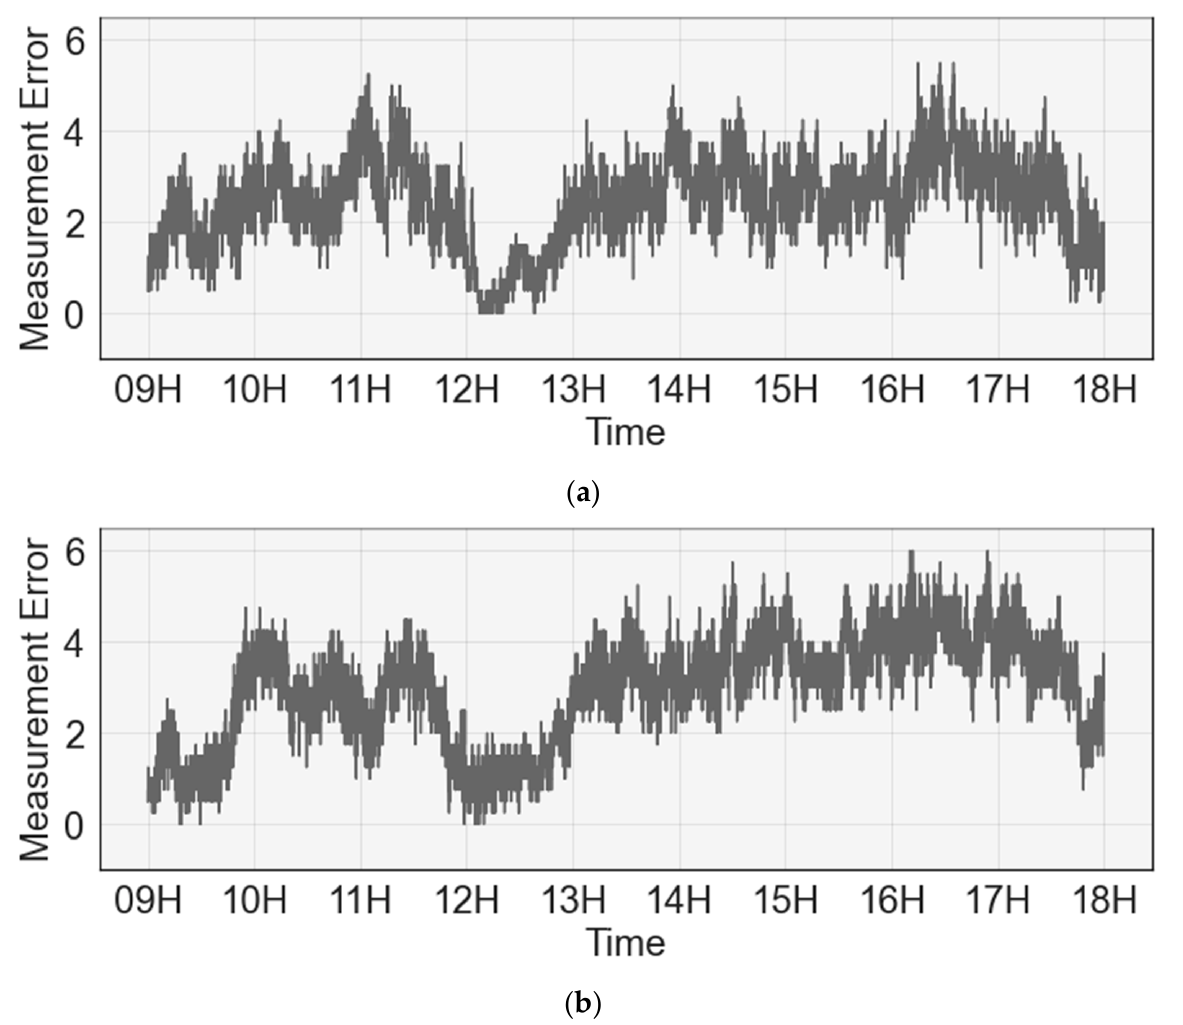
Figure 7. Analysis of time-zone error between sensing and ground-truth data: ( a ) average measure- ment error in room 1; ( b ) average measurement error in room 2.